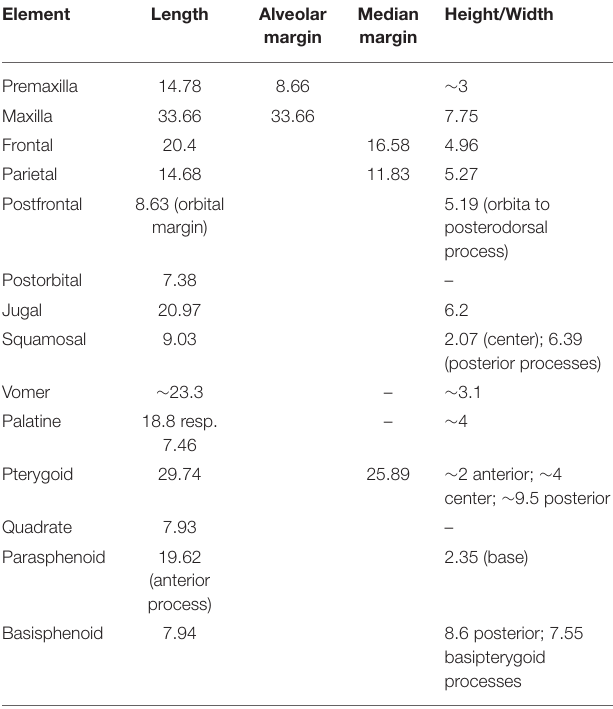
TABLE 1 | Measurements (in mm) of the skull bones of PIMUZ T 1559.